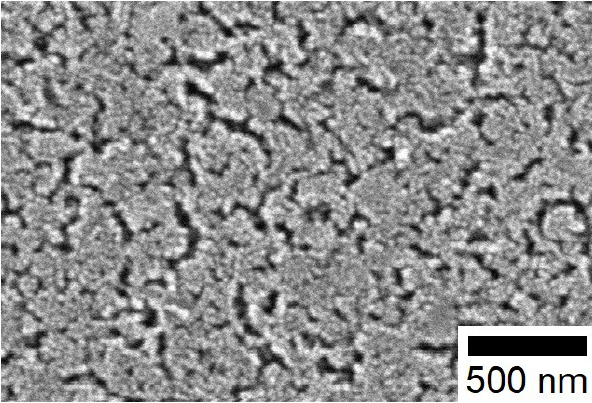
Figure 2. High magnification SEM micrograph of i :ZnO thin film.